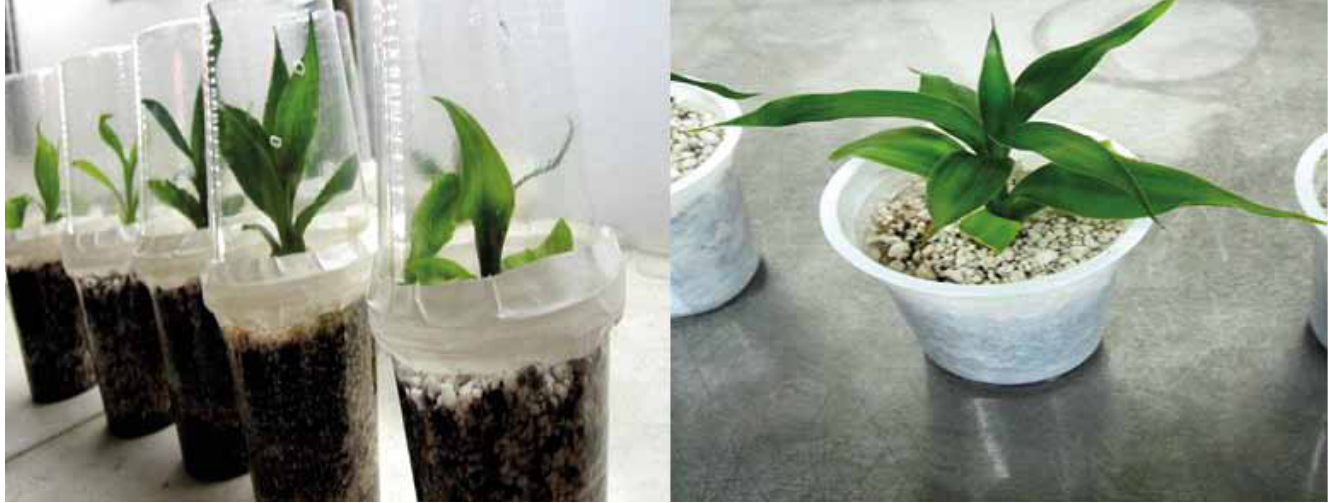
Fig. 3 - ‘Green’ plantlets transferred to the